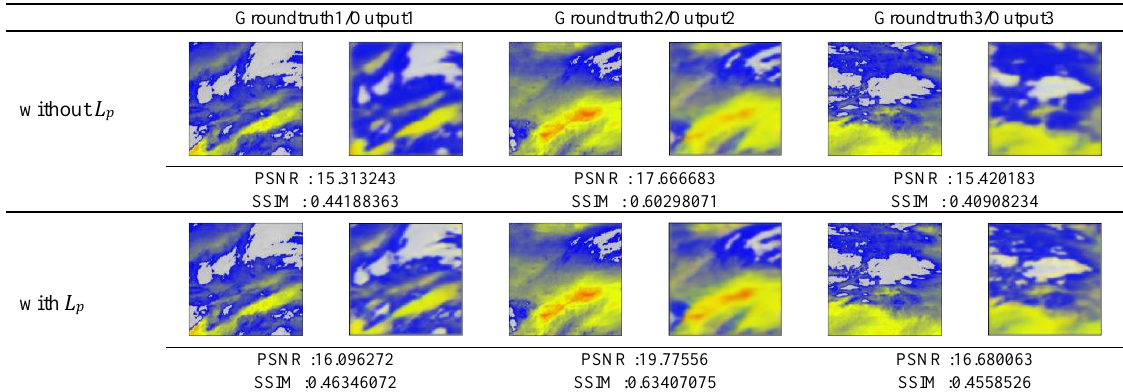
Table 2. The ground truth images 、 output images and the value of PSNR and SSIM with and without 𝐿